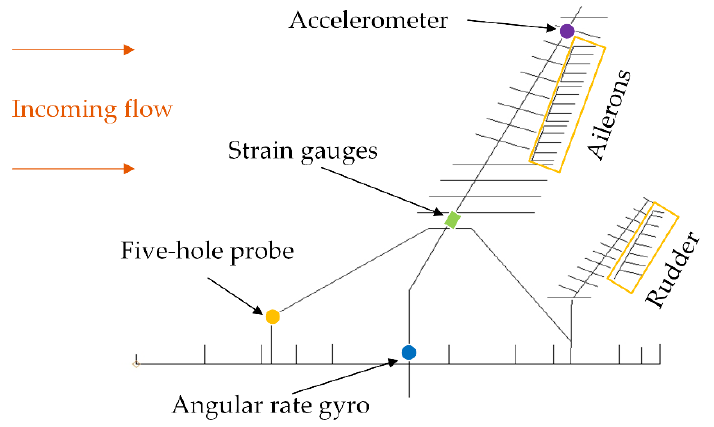
Figure 13. Top view of finite element model and sensor installation locations. Table 1. Comparison between measured and theoretical values of modal frequencies.